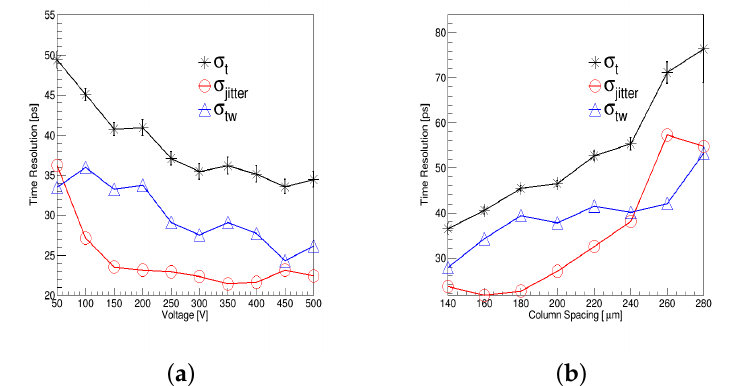
Figure 7. (Color online.) The distribution of σ tw , σ jitter , and σ t with ( a ) different voltage and ( b ) differ- ent column spacing.